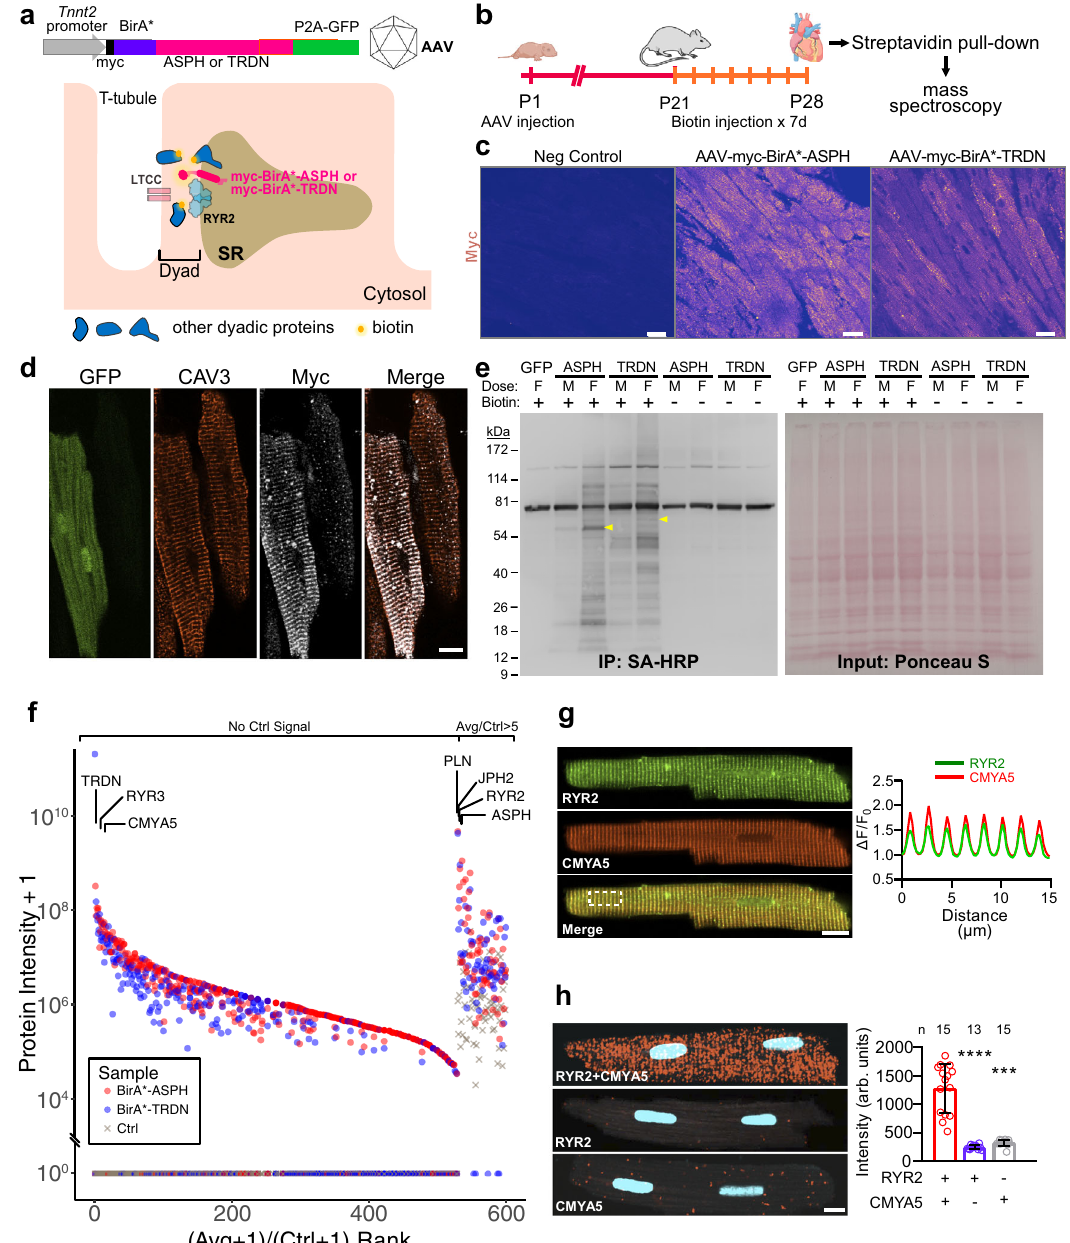
Fig. 1 BioID identi fi cation of dyadic proteins. a Proximity proteomics strategy. BirA* and myc epitopes were fused to ASPH and TRDN, which interact with RYR2 in jSR of dyads. N-terminal fusion positions BirA* in the dyadic cleft. The fusion protein was expressed in vivo in cardiomyocytes using AAV9 and the cardiomyocyte-selective troponin T (Tnnt2) promoter. GFP was co-expressed using a P2A sequence. b Experimental timeline. Artwork from biorender.com. c Expression of BirA* dyadic biosensors in myocardium. Heart sections were stained for the myc epitope tag. Most cardiomyocytes were immunoreactive. Bar = 20 µ m. Representative of 3 independent experiments. d Mature ventricular cardiomyocytes. In the left GFP + cell, myc